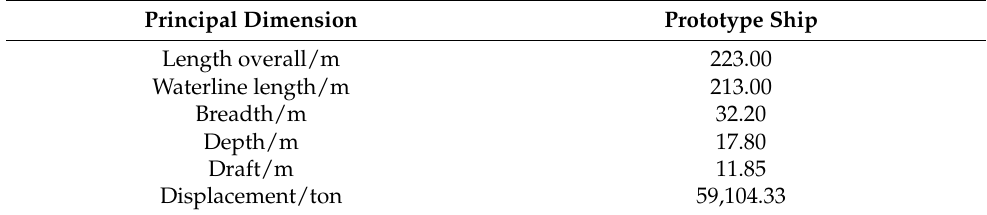
Figure 1. Finite element model of the bulk carrier. Table 1. Main parameters of the bulk carrier.